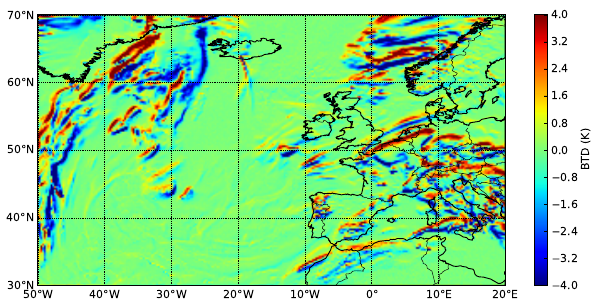
Fig. 10. The 10.8µm brightness temperature difference between a full 3-D simulation and a simulation utilizing the independent pixel approximation.